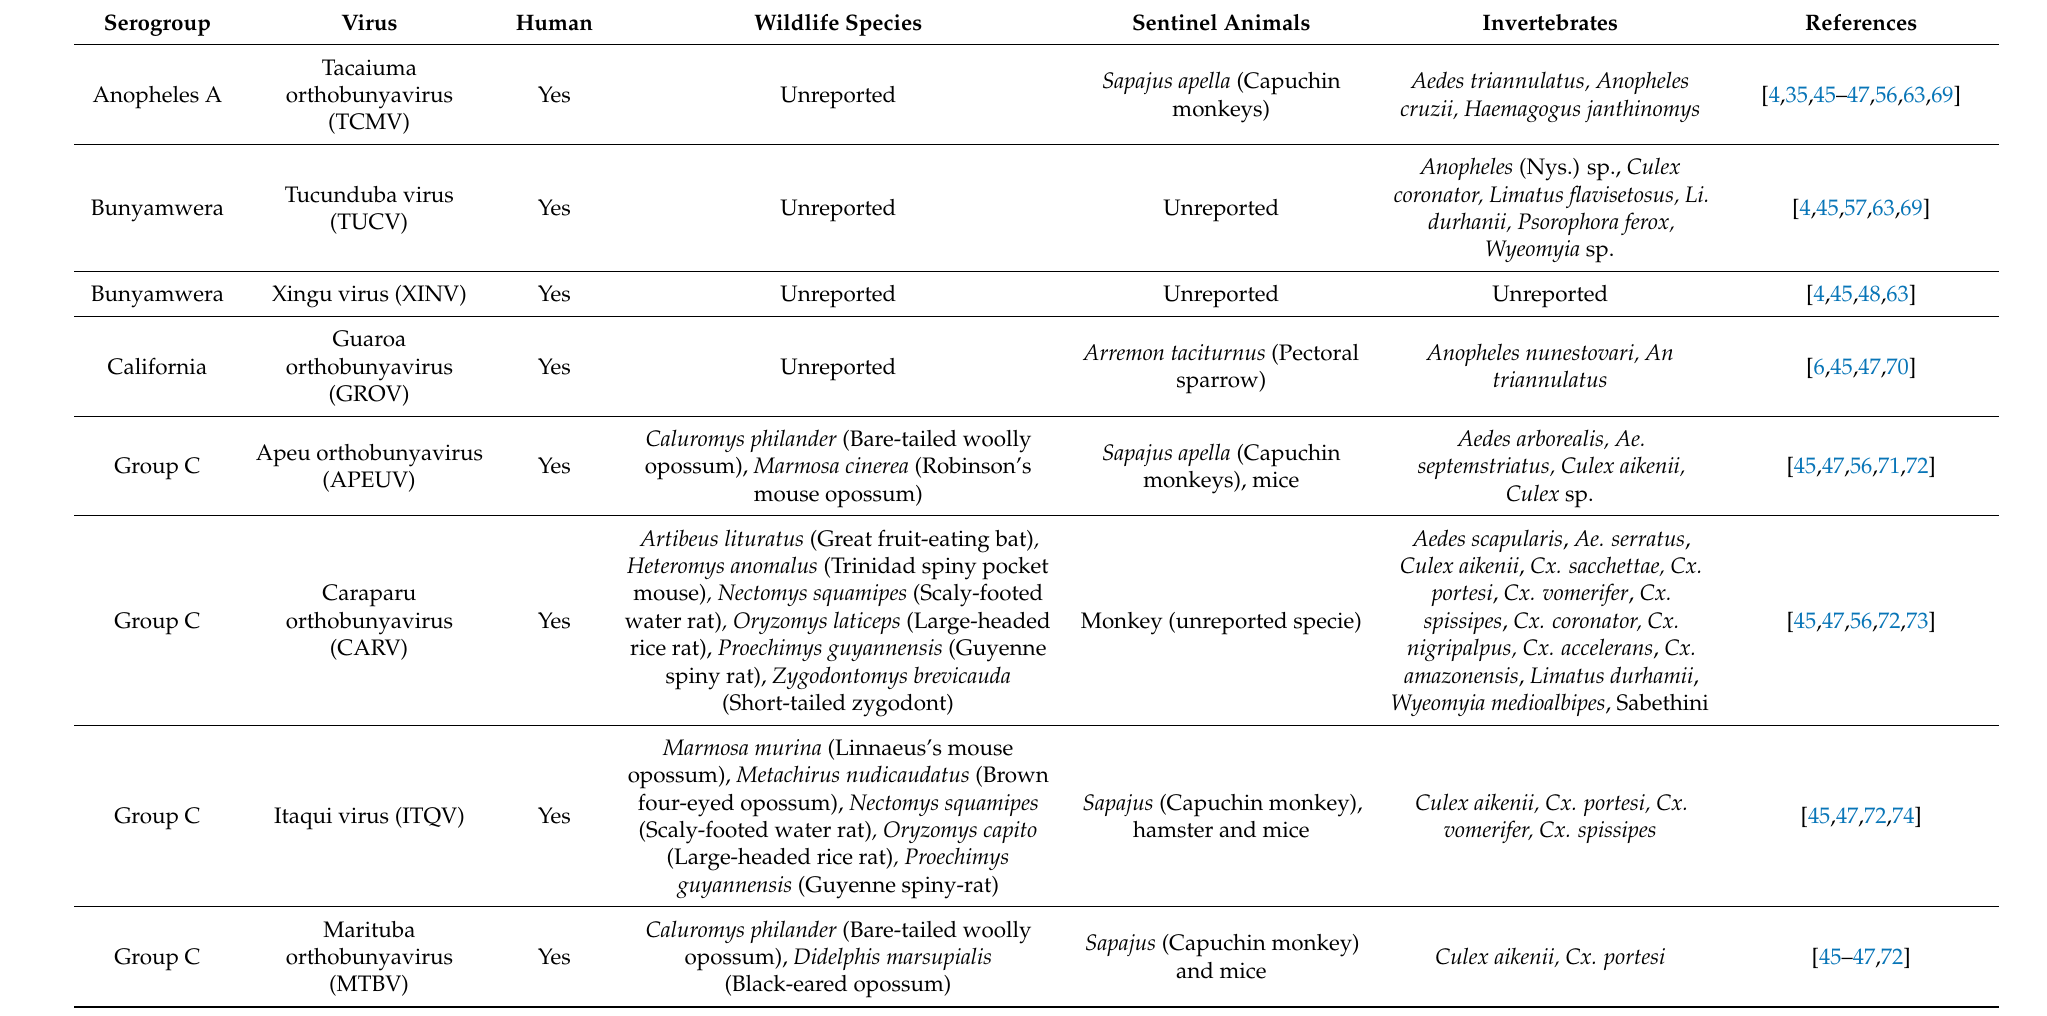
Table 1. Summary of human pathogenic orthobunyaviruses isolated in